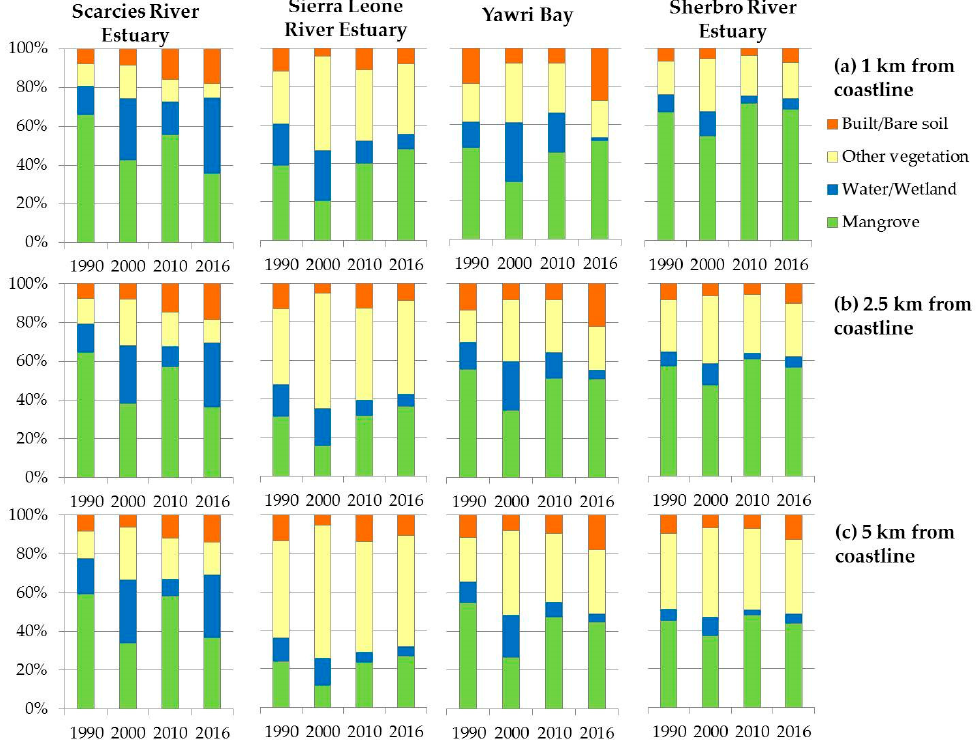
Figure 5. Relative extents of different land covers within the four focus areas during 1990–2016. Panels show mangrove extents within buffers of ( a ) 1 km, ( b ) 2.5 km, ( c ) 5 km extending inland from the